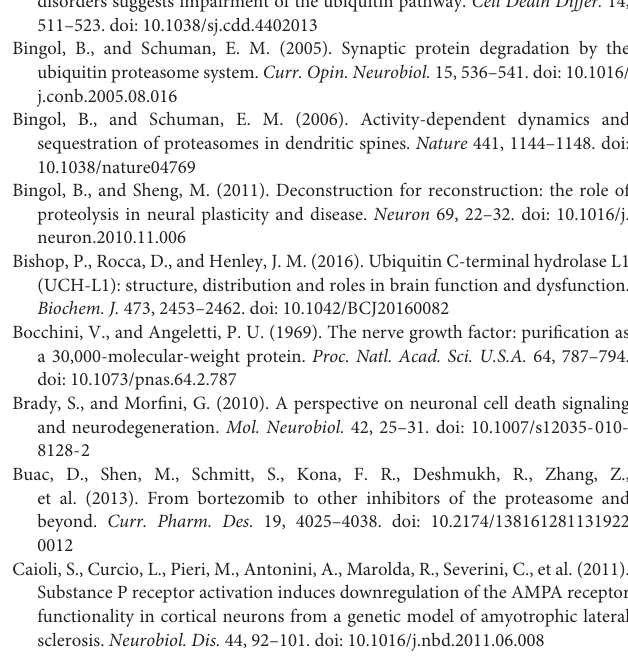
neurons ( t 0 ) and reported as mean ± SEM. Statistically significant differences were calculated by unpaired-two tailed t -Student’s test [ ∗∗ p < 0.01 vs. t 0 control neurons ( ◦ ) and vs. − 6 h NGF deprivation (§n.s., not significant)]. FIGURE S4 | (A,B) Septal cholinergic-enriched cultures were grown continuously (10–12 D.I.V.) in 0.2% B27 media in the presence of exogenous NGF (100 ng/ml) from plating ( t 0 ) and then deprived of their trophic support for 6 h ( − 6 h) in the absence or presence of CQ (10 µ M) and MG132 (10 µ M). Western blotting analysis carried out on whole-cell extracts by probing for synapsin I, α -synuclein and β -actin (A) and relative densitometric quantification (B) were shown. Data were reported as mean ± SEM. and expressed ratio of the value from control neurons ( t 0 ). Statistically significant differences were calculated at the respective experimental points by unpaired-two tailed t -Student’s test [ ∗∗ p < 0.01 vs. t 0 control neurons ( ◦ ) and vs. − 6 h NGF deprivation (§)]. FIGURE S5 | (A,B) Western blotting analysis for UCHL-1 (A) was carried out on equal amounts of total protein extract (20 µ g) from septal primary neurons cultured for 10–12 D.I.V. in defined medium supplemented with 0.2% B27, in the presence ( t 0 ) or absence ( − 1.5, − 3, − 6 h) of exogenously added NGF (100 ng/ml). Relative densitometric quantification (B) by normalization on β -actin, which was used as internal control for samples loading, was reported. Data ( n = 3) were reported as mean ± SEM. and expressed ratio of the value from control neurons ( t 0 ). Notice that there is in neuronal cultures an increase of the UCHL-1 expression level induced by the time-dependent NGF removal but values does not reach statistical significance by unpaired-two tailed t -Student’s test ( − 1.5 h p = 0.1750; − 3 h p = 0.1424; − 6 h, p < 0.0676 vs. t 0 control neurons). FIGURE S6 | (A,B) Septal cholinergic-enriched cultures were grown continuously (10–12 D.I.V.) in 0.2% B27 media in the presence of exogenous NGF (100 ng/ml) from plating ( t 0 ) and then deprived of their trophic support for 6 h ( − 6 h) in the absence or presence of MG132 (2.5 µ M), LDN (2.5 µ M), and MG132 (2.5 µ M) + LDN (2.5 µ M) combination. Levels of synapsin I and synuclein were assessed by Western blotting analysis and β -actin was used as loading control (A) . Relative densitometric quantification (B) was calculated as ratio of the value from control neurons ( t 0 ) and reported as mean ± SEM. Statistically significant differences were calculated at the respective experimental points by unpaired-two tailed t -Student’s test [ ∗ p < 0.05, ∗∗ p < 0.01 vs. t 0 control neurons ( ◦ ) and vs. − 6 h NGF deprivation (§)].